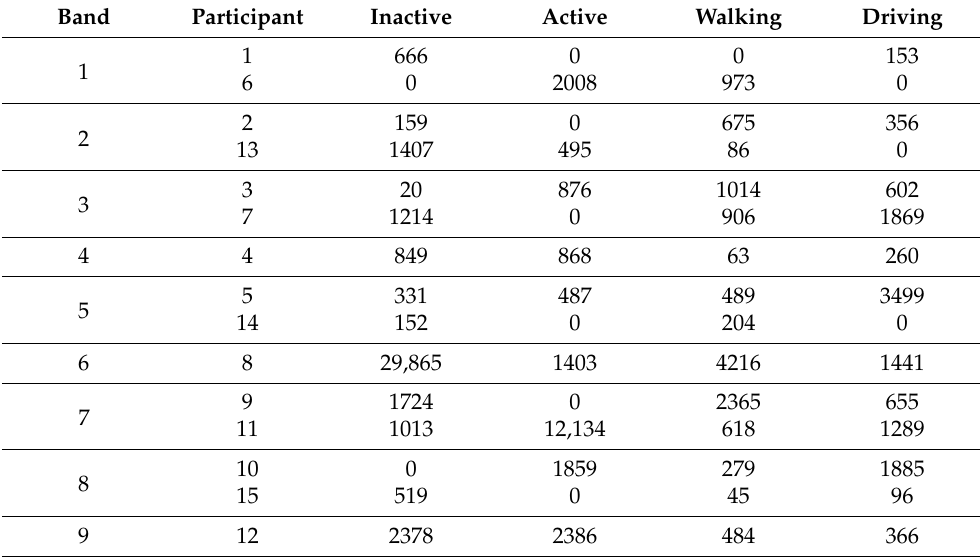
Table 3. Participant Bands for LOSO cross-validation.